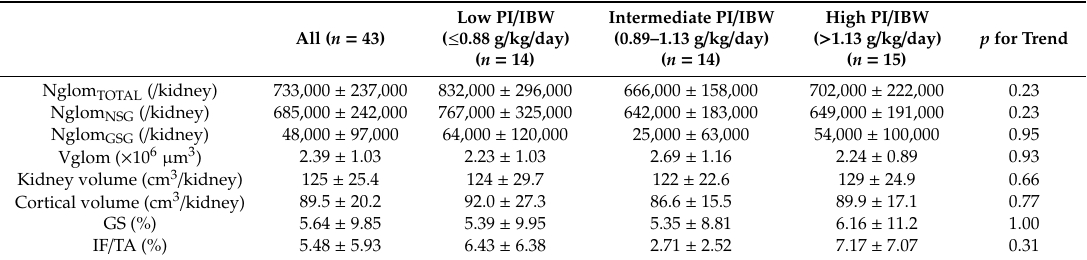
Table 2. Histopathological characteristics and morphometric data among all subjects and according to protein intake per ideal body weight